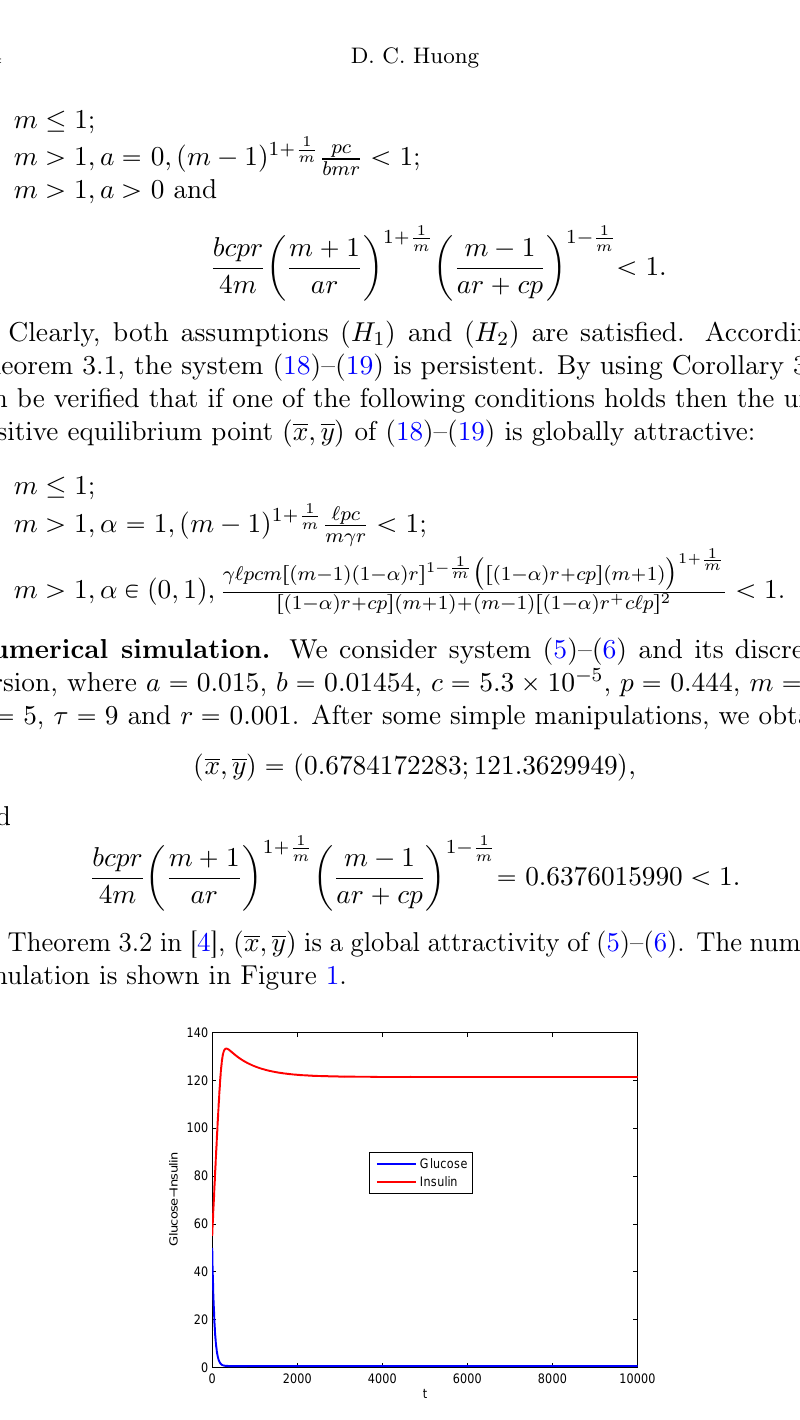
Fig. 1. Plot of the continuous model with p x, y q “ p 0 . 6784172283 , 121 . 3629949